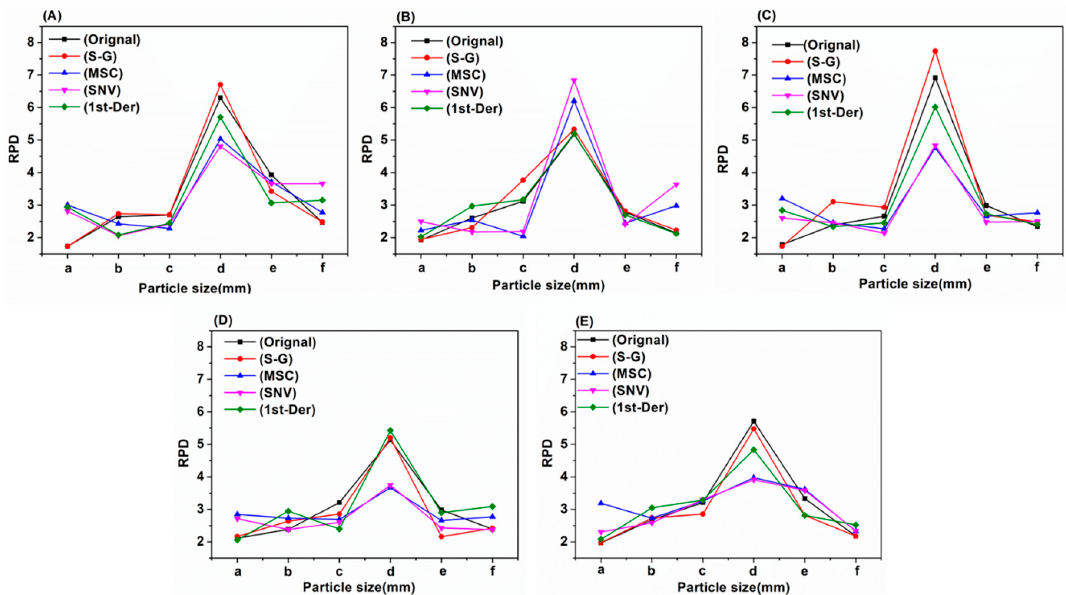
Figure 5. The residual predictive deviation (RPD) of four different preprocessing methods and five different models. Models: ( A ) PLS; ( B ) CARS-PLS; ( C ) biPLS; ( D ) GA-PLS; ( E ) SPA-PLS. Soil particle sizes: (a) 1–2 mm; (b) 0.45–1 mm; (c) 0.28–0.45 mm; (d) 0.18–0.28 mm; (e) 0–0.18 mm; (f) 0–2 mm.